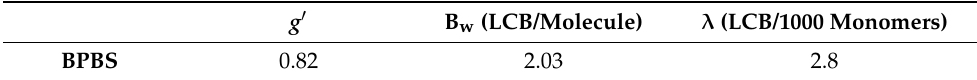
Table 3. Long-chain branching characteristics. Viscosity branching index, average LCB per